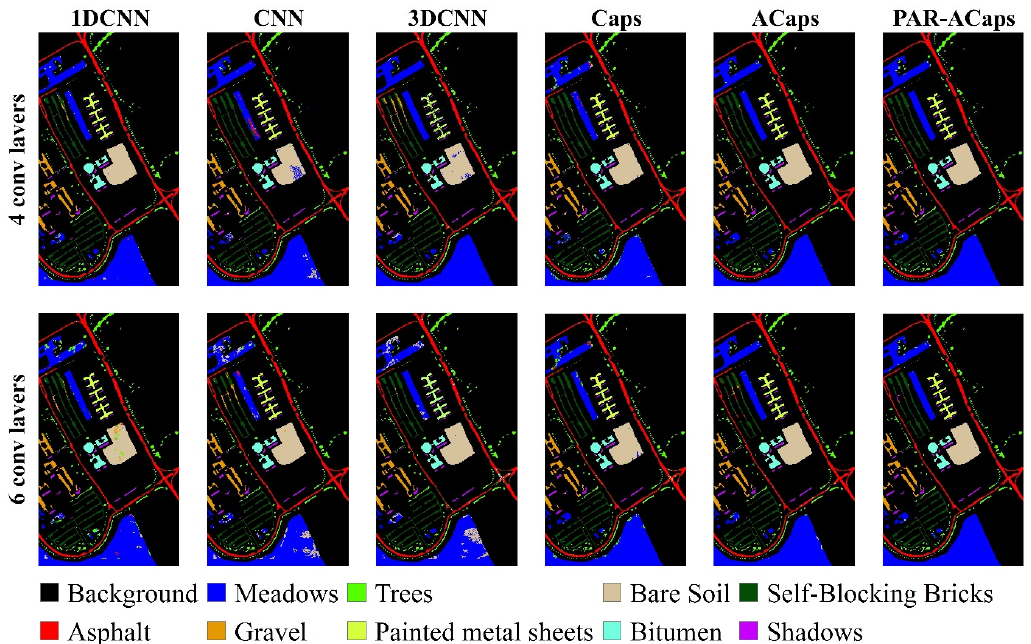
Figure 11. The classification results of PU dataset derived from 1DCNN, CNN, 3DCNN, Caps, ACaps, and PAR-ACaps with four and six convolutional layers.